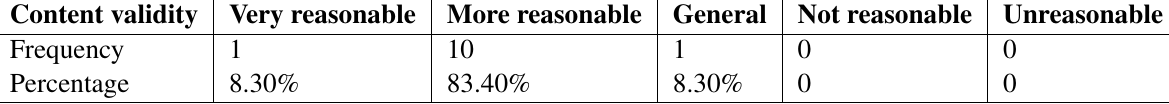
Table 5 Test of the overall design validity of the